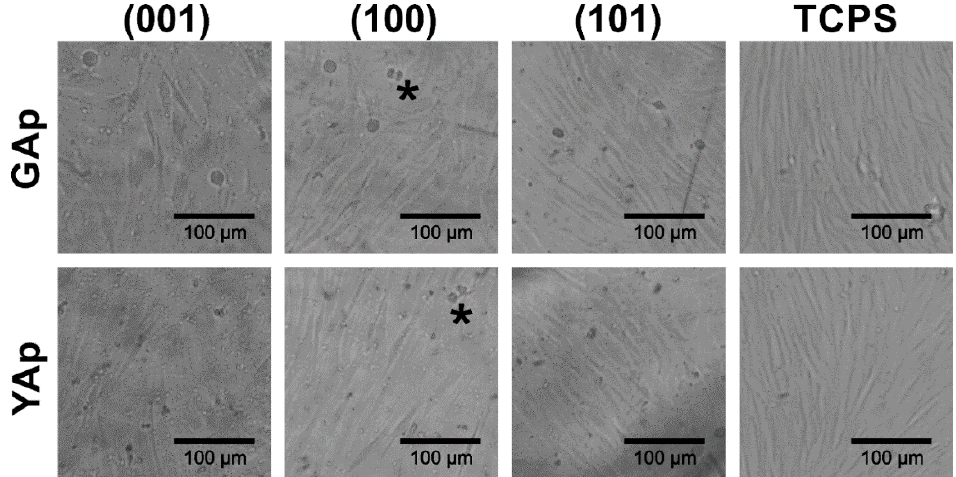
Figure 5. The fibroblasts morphology on the GAp and YAp plates and TCPS substrates after 48 h of incubation. The exemplary dividing cells are marked with the asterisks.